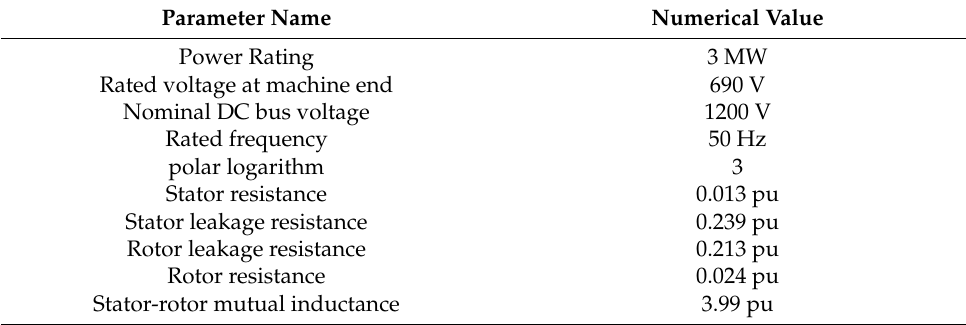
Table 2. Main parameters of DFIG.